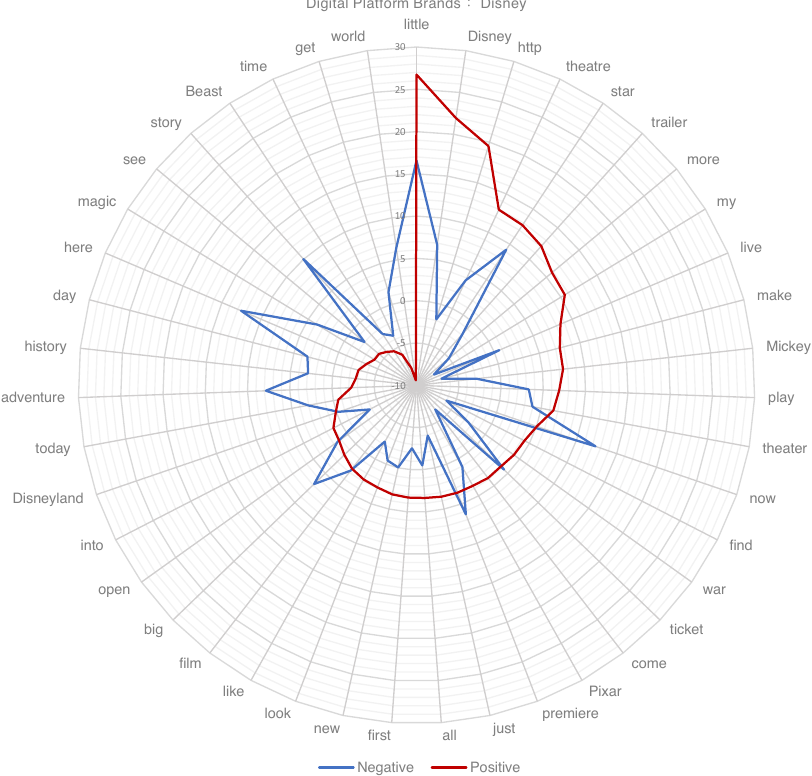
Fig. 6 Cues of Disney, using ensemble learning, this study obtained positive and negative clues from the posts of the “ Disney ” fan